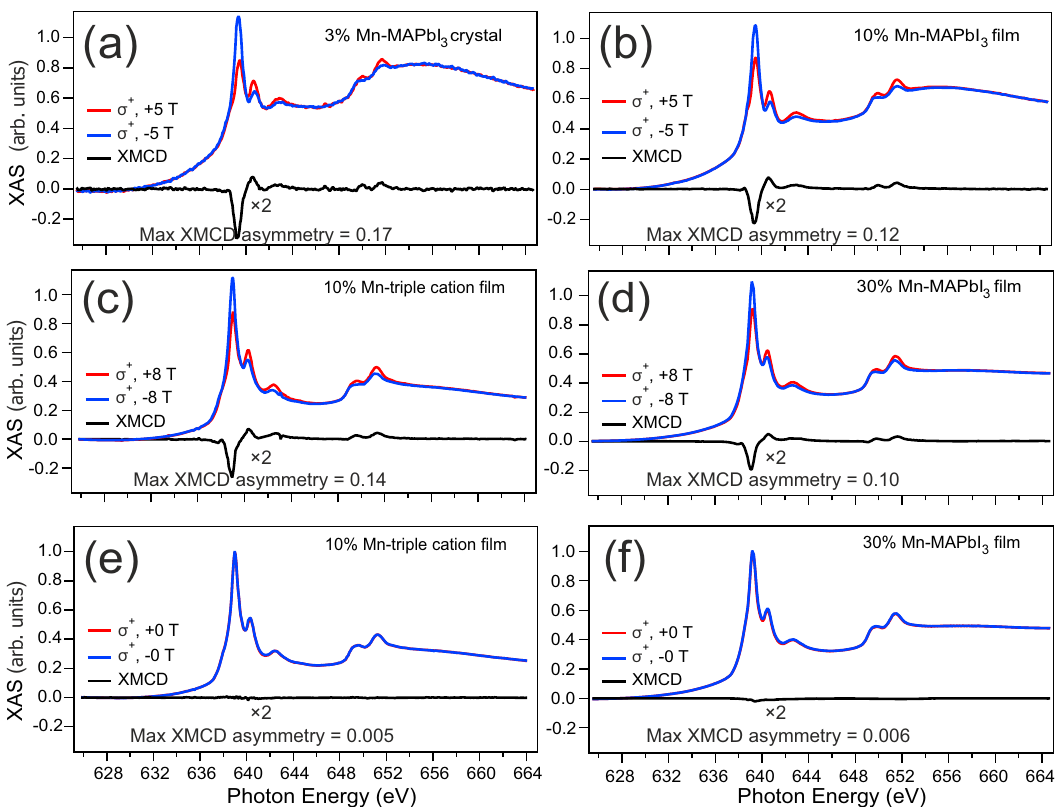
Fig. 2 Low-temperature (8.5 K) Mn L 2,3 X-ray absorption spectroscopy (XAS) and corresponding X-ray magnetic circular dichroism (XMCD) spectra in total electron yield. a MAMn 0.03 Pb 0.97 I 3 single crystal, b MAMn 0.1 Pb 0.9 I 3 fi lm, c triple-cation fi lm with 10% Mn, and d MAMn 0.3 Pb 0.7 I 3 fi lm. Measurements of a and b are performed under a magnetic fi eld of ±5 T, while c and d are measured under ±8 T. e , f Represent the XAS/XMCD spectra under the fi eld of ±0 T after magnetization at 8 T for triple-cation with 10% Mn and MAMn 0.3 Pb 0.9 I 3 fi lms, respectively. The magnetic fi eld is applied a , b perpendicular, and c – f parallel to the Figure 2 shows the normalized Mn L 2,3 absorption edge spectra for right-handed circularly polarized light ( σ + ) at magnetic fi elds of 0, 5, and 8 T and at cryogenic temperature ( T = 8.5 K). The photon energies of the Mn L 3 and L 2 edges, which have been used to measure magnetic hysteresis loops, are 639 and 651 eV, respectively. The differences between the XAS spectra measured with positive (red) and negative (blue) magnetic fi elds, i.e., XMCD spectra (black lines) at both the L 3 and L 2 edges, indicates strong magnetization of Mn local moments and large spin polarization of Mn d 5 states at 5 and 8 T [Fig. 2a – d]. The XMCD signal clearly changes sign between the low-energy L 3 and high- energy L 2 edges, as expected. Among the systems studied, the monocrystal of MAMn 0.03 Pb 0.97 I 3 demonstrates the largest XMCD asymmetry ( I ( σ + ) − I ( σ − ))/( I ( σ + ) + I ( σ − )) of 0.17 at 8.5 K.